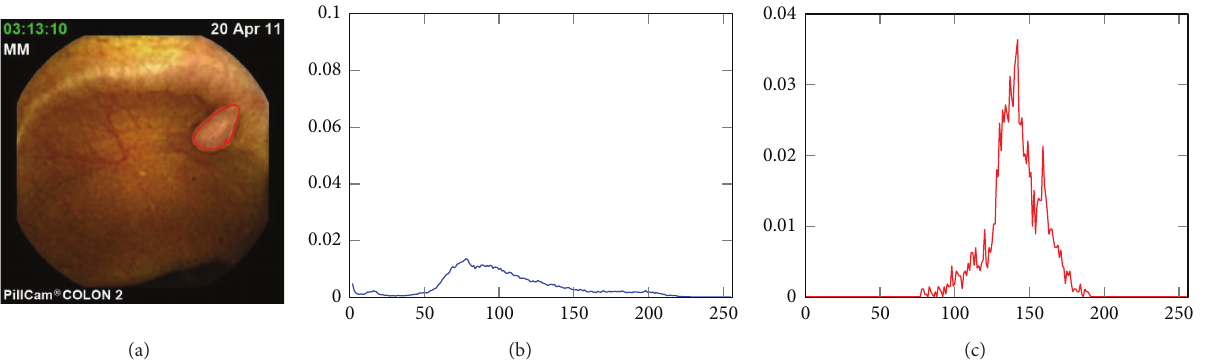
Figure 6: Illustration of the non-Gaussianity of the PDF (luminance) extracted from a WCE image presenting with a polyp. (a) Delineation of the polyp, (b) luminance PDF of the inner (polyp) region, and (c) PDF of the outer (background)